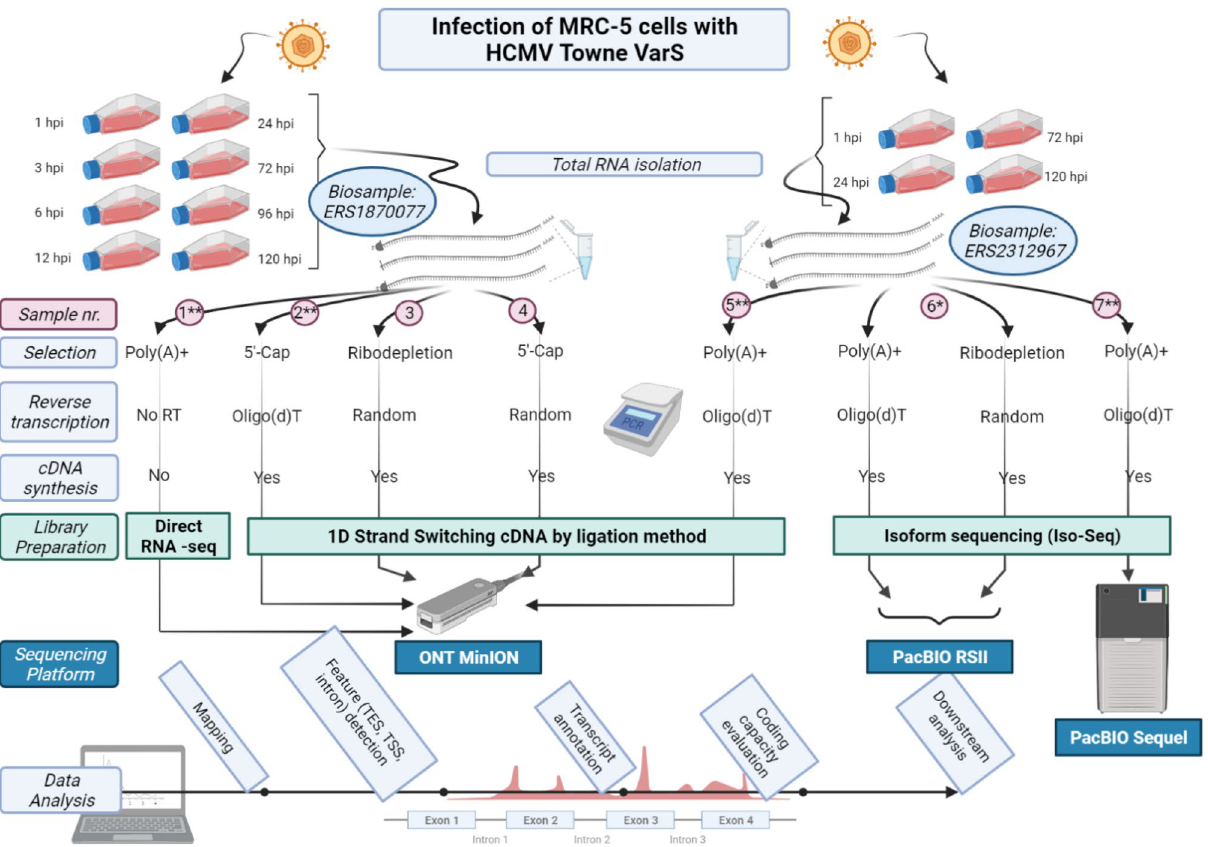
Figure 1. An overview of the utilized sequencing platforms, library preparation and sequencing methods and bioinformatic analyses of the resulting sequencing reads. The sample numbers in this figure correspond to the sample numbers in Table 1. The star in sample_6 (RSII) indicates that the data and analysis from this sample have been reported in our previous publication, while double stars indicate that only the sequencing data have been published in our previous publication. Created with BioRender.com.